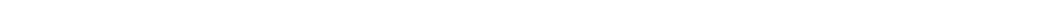
(see fi gure on previous page) Fig. 3 The RHEB p.Y35L mutation induces neuronal migration defects, cytomegalic neurons, and mTOR pathway activation in vivo. E14.5 mouse embryos were electroporated with control vehicle, wild-type (WT) or p.Y35L RHEB plasmids coexpressing GFP through an IRES sequence. a At E18.5, embryos were collected and brain coronal sections were stained with DAPI and imaged under a confocal microscope. WT and p.Y35L sample images were aligned in the same orientation and roughly de fi ned into two bins, with bin 1 representing the regions below the cortical plate and bin 2 representing the cortical plate. GFP-positive cells are indicated in green, and nuclei are indicated in blue. Scale bars: 100 μ m. b The percentage of GFP + neurons in each bin was quanti fi ed according to the fl uorescence intensity using ImageJ. Data are presented as the mean±s.e.m, n = 4, * P <0.05 (Student ’ s t -test). c At E18.5, embryo brain coronal sections were immunostained using an anti-phosphorylated S6 (pS6) antibody and a corresponding secondary antibody. Images were acquired by confocal microscopy. GFP (green) and the pS6 immunoreactivities (red) were visualized as indicated. Scale bars: 20 μ m. Soma sizes of GFP-positive cells ( d ) and colocalization of GFP and pS6 ( e ) as indicated by yellow convergent signals in c were quanti fi ed using ImageJ for comparison. Data are presented as the mean±s.e.m, n = 4, * P <0.05, ** P <0.01 (Student ’ s t -test). f At P30, electroporated brain samples were immunostained using an anti-NeuN antibody and a corresponding secondary antibody, and images were acquired by confocal microscopy. GFP (green) and NeuN immunoreactivity (red) were visualized as indicated. Scale bars: 20 μ m. g Soma sizes of GFP- and NeuN-double positive cells in f were quanti fi ed using ImageJ. Data are presented as the mean±s.e.m. *** P <0.001 (Vehicle: n = 3, WT: n = 4, p.Y35L: n = 3, one-way ANOVA with Tukey ’ s post test)